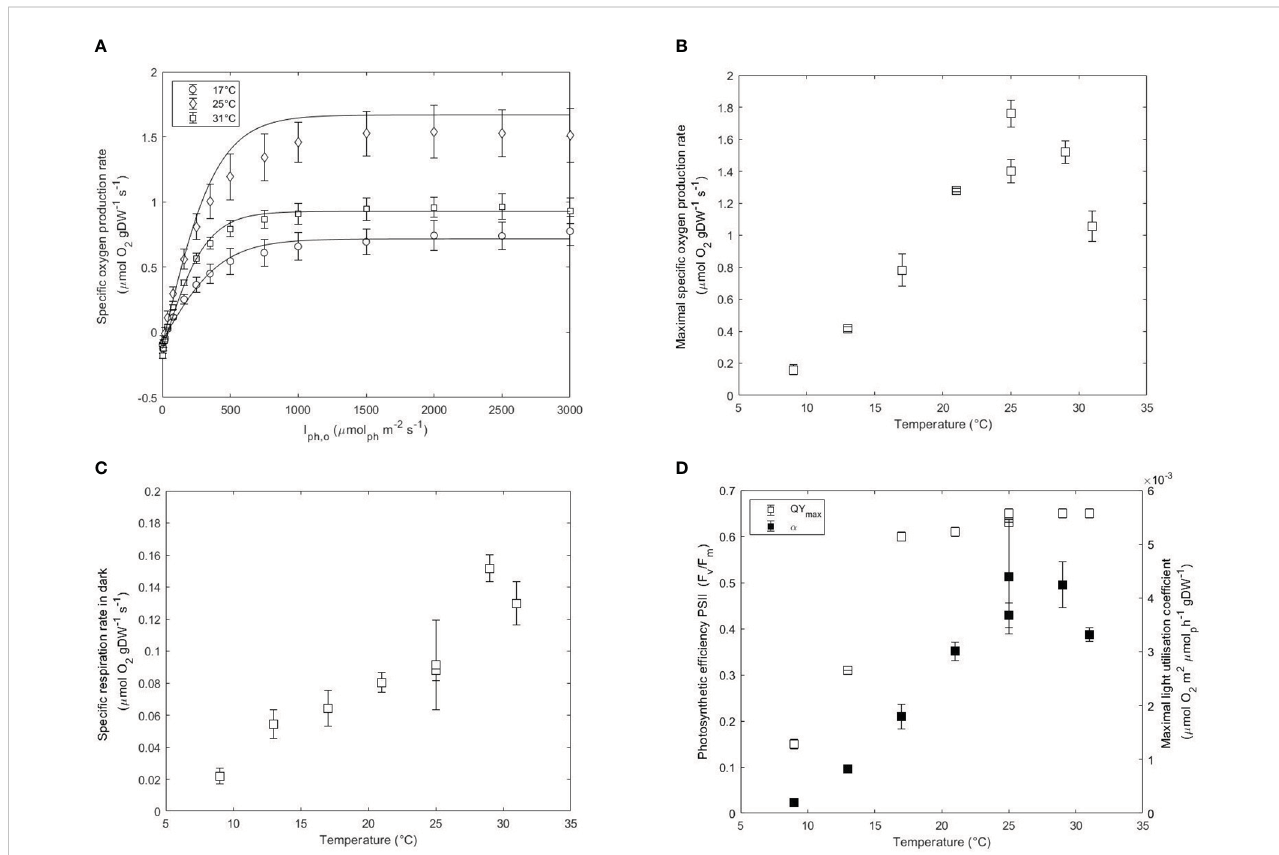
FIGURE 2 (A) Photosynthesis-Irradiance (PI) curves at 17, 25 and 31°C. Maximal speci fi c oxygen production rate (q max O dark (q dark O , m mol gDW -1 s -1 ) (C) , and QY max (F v /F m ) and maximal light utilisation rate ( a , m mol O 2 m 2 m mol ph -1 gDW -1 ) (D) as a function of temperature in 2 acclimated cultures of N. oceanica . Error bars represent the standard deviation of three measurements. Two independent runs were performed at 25°C to assess the reproducibility of the